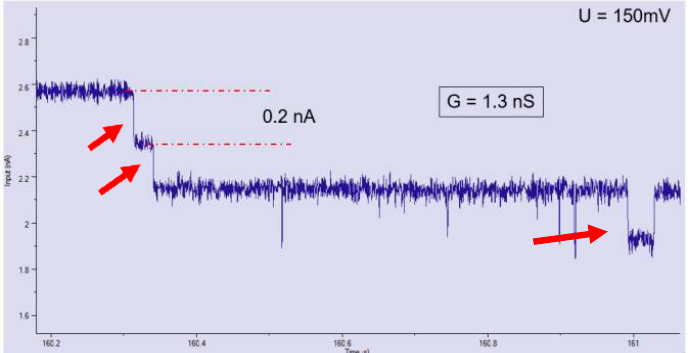
Figure 4. Current response of porin OmpF after successful integration in a synthetic bilayer. The lipid bilayer is supported in a 200 µm Parylene coated aperture. The measured current increment is 0.2 nA per pore opening (pointed by arrows) resembling ion transport through the protein pores fused in the bilayer at a 150 mV holding